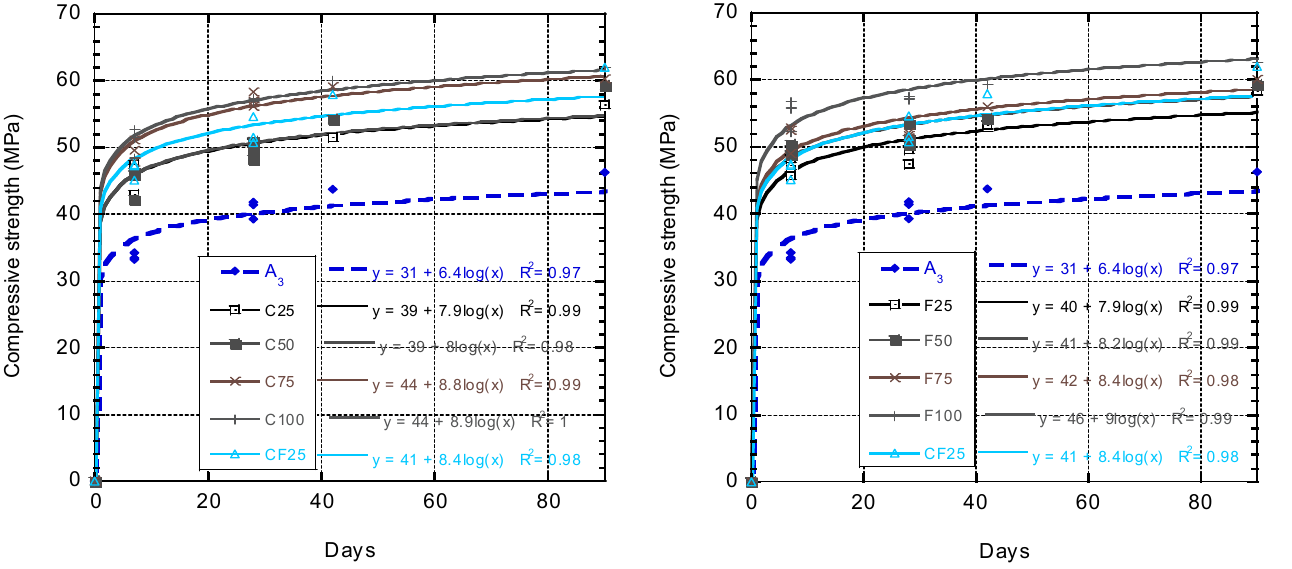
Figure 9. Compressive strength of replaced EAFS coarse aggregates concrete ( left ) and EAFS fine aggregates concrete ( right ).